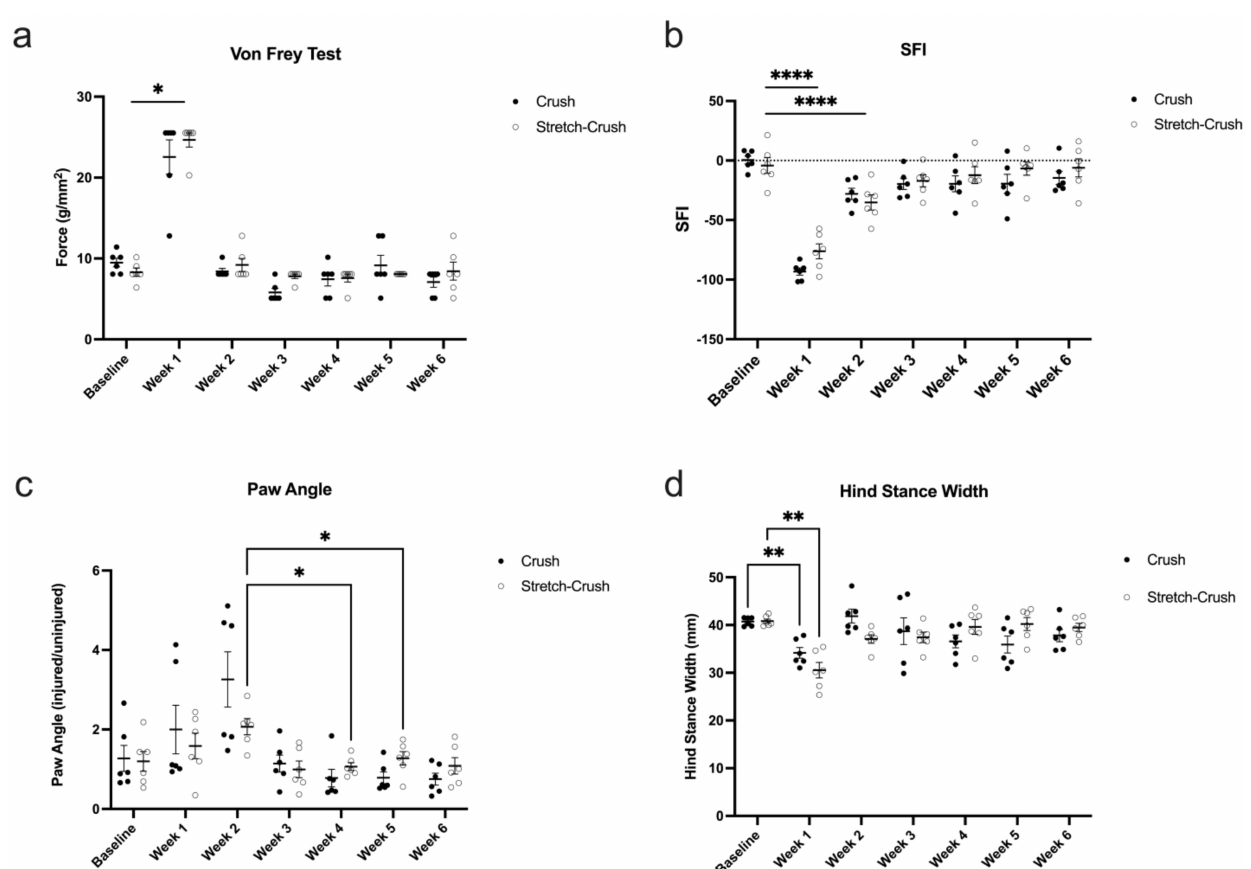
Figure 5. Behavioral and VGL metrics evaluated over six weeks. Results of crush-injured nerves compared to stretch–crush injured nerves and contralateral uninjured nerves (sham). ( a ) Von Frey test shows significant differences at week one in both groups compared to baseline, with a return towards baseline thereafter. ( b ) SFI follows a similar temporal profile of recovery as ( a ) with statis- tically significant measurements for both groups at week one and two compared to baseline. For HPA ( c ), measured as the ratio of the injured leg’s paw angle over the uninjured leg’s paw angle as assessed by VGL between injury models and across time, there was a surprising peak at week two. No significant differences between injury models were demonstrated; there was a trend, but nonsignificant interaction, between injury type and time (stretch–crush at week two compared to week four and five, p = 0.0672). ( d ) HSW analysis as assessed by VGL between injury models and across time showed significant differences for both groups at first week compared to baseline, with a similar kinetics of recovery over time, as the von Frey test ( a ) with return to baseline thereafter. Statistics were performed using a two-way repeated measures ANOVA. Error bars represent standard error of the mean (SEM). * = p < 0.05, ** = p < 0.01, **** = p < 0.0001. ANOVA, analysis of variance; HPA, hind paw angle; HSW, hind stance width; NCV, nerve conduction velocity; SFI, sciatic functional index; VGL, Visual Gait